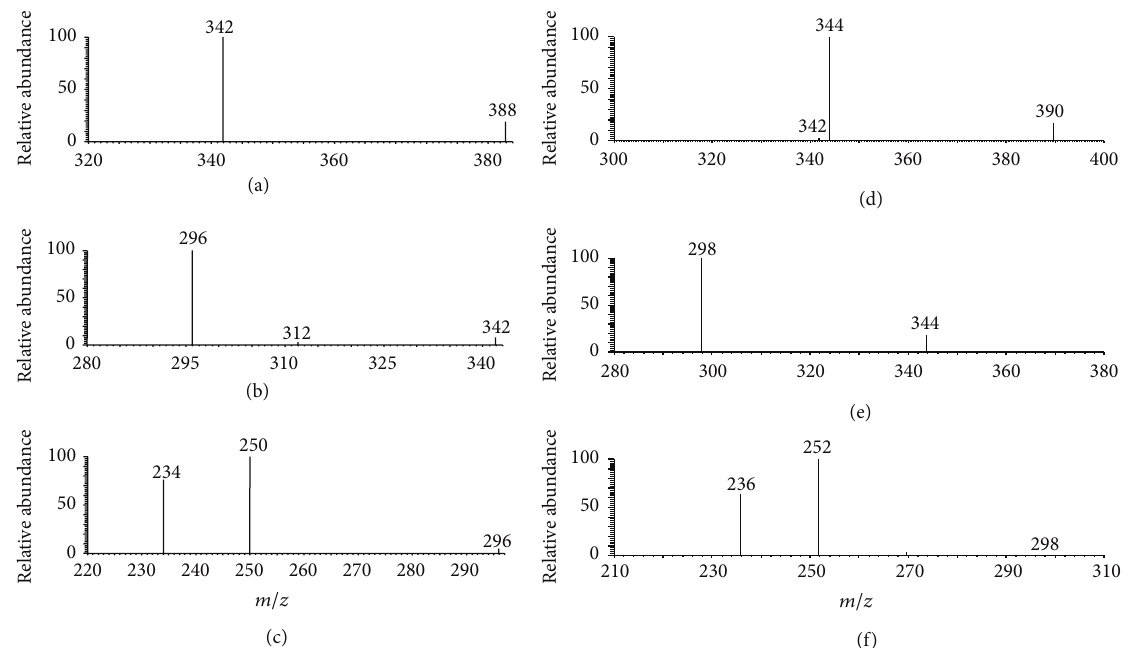
Figure 5: MPT-MS 𝑛 mass spectra of precursor anions of 𝑚/𝑧 388 and 390 ( 𝑛 up to